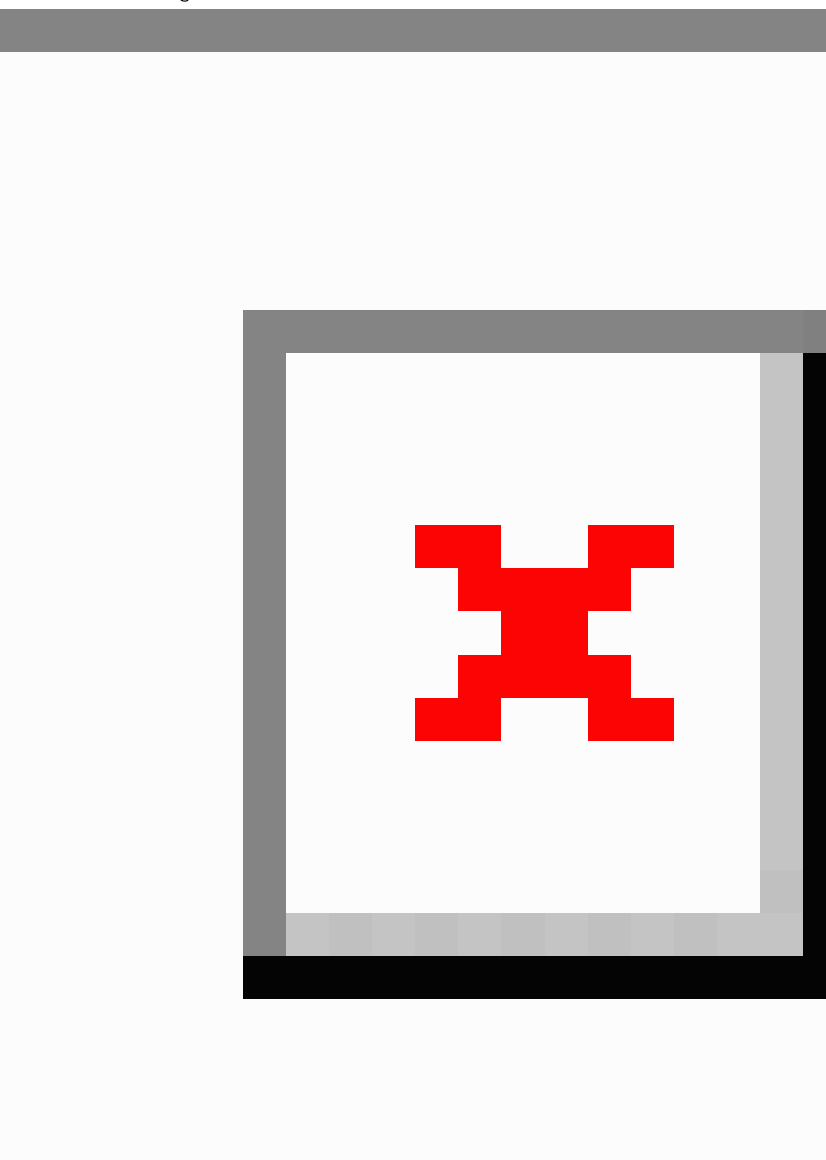
Figure 1. Flow of studies through the